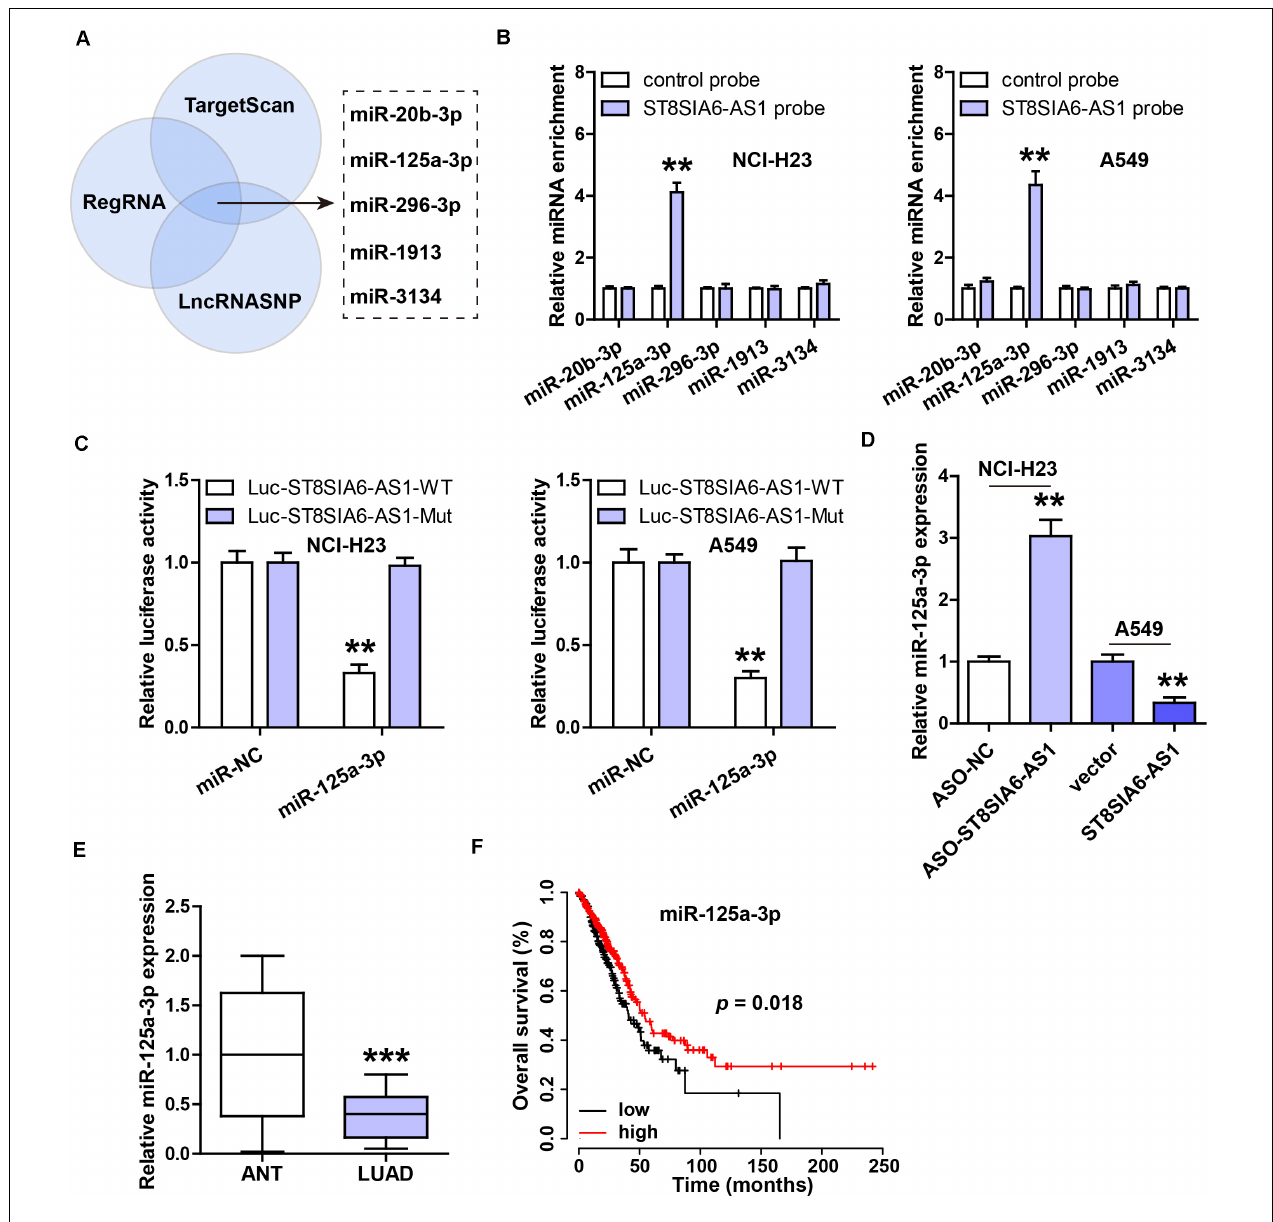
FIGURE 4 | ST8SIA6-AS1 sponges miR-125a-3p in LUAD cells. (A) Three online databases predicting miRNAs bound by ST8SIA6-AS1. (B) RNA pull-down assay using biotinylated ST8SIA6-AS1 probe, followed by qRT-PCR analysis. (C) Luciferase reporter assay testing the inhibitory effect of miR-125a-3p on ST8SIA6-AS1. (D) qRT-PCR analysis of miR-125a-3p level after alteration of ST8SIA6-AS1 expression. (E) qRT-PCR analysis of miR-125a-3p expression in LUAD and matched normal tissues. (F) The survival curve of LUAD patients based on miR-125a-3p level. ** P < 0.01, *** P < 0.001.